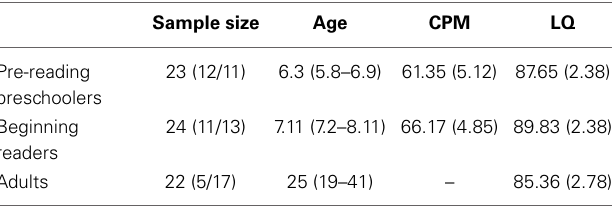
Table 1 | Sample size (number of girls/boys and females/males, respectively), age (mean year/month for children and mean years for adults, with respective ranges), mean IQ-score (percentile rank with standard error of mean) accessed with CPM (Bulheller and Häcker, 2002) and handedness (lateralization quotient, LQ, with standard error of mean) accessed by the Oldfield Handedness Questionnaire (Oldfield, 1971) are